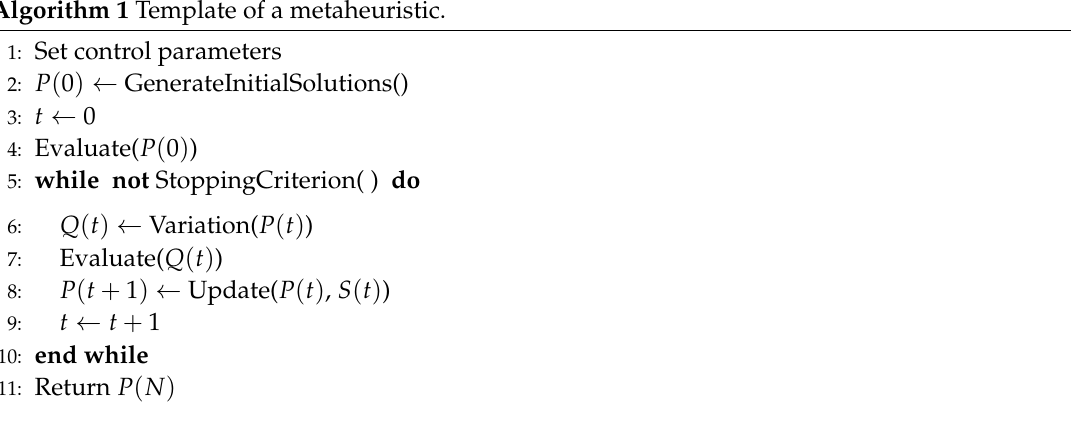
Algorithm 1 Template of a